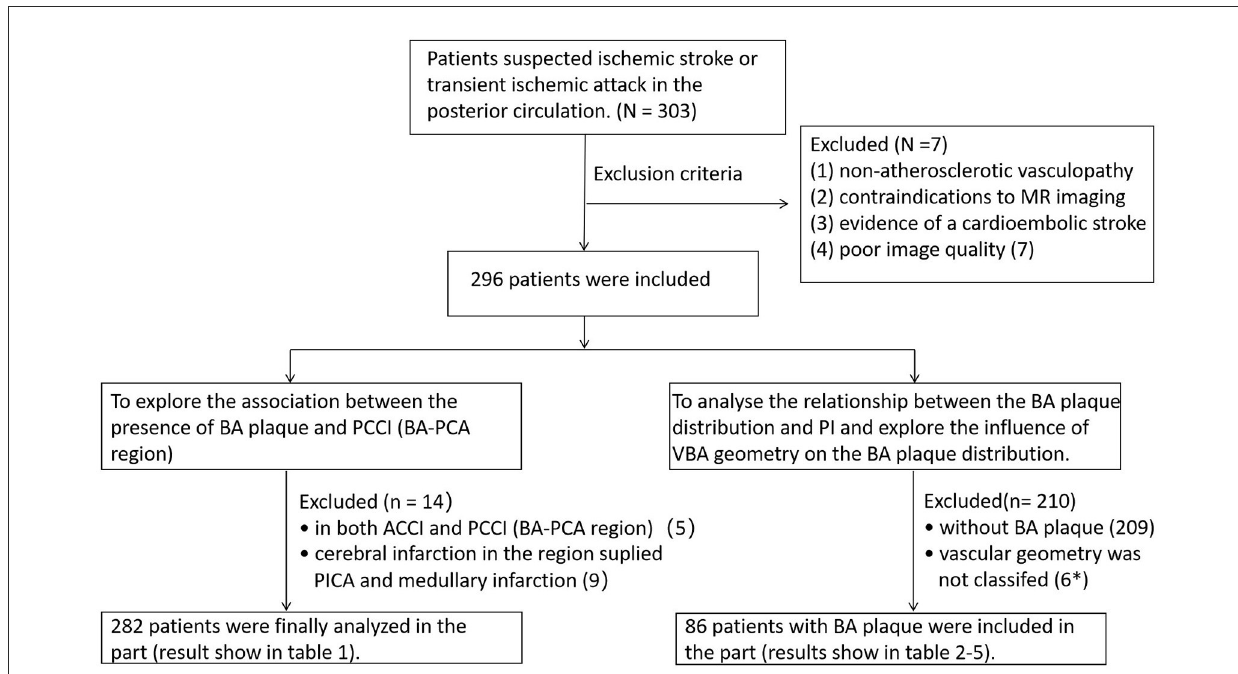
FIGURE1 Flow diagram of patient enrollment. * Six patients vascular geometry were not classified, and five patients without BA plaque. BA, brasilar artery; VBA, vertebrobasilar artery; PI, pontine infarction; ACCI, anterior circulation cerebral infarction; PCCI, posterior circulation cerebral infarction; PCA, posterior cerebral artery; PICA, posterior inferior cerebellar